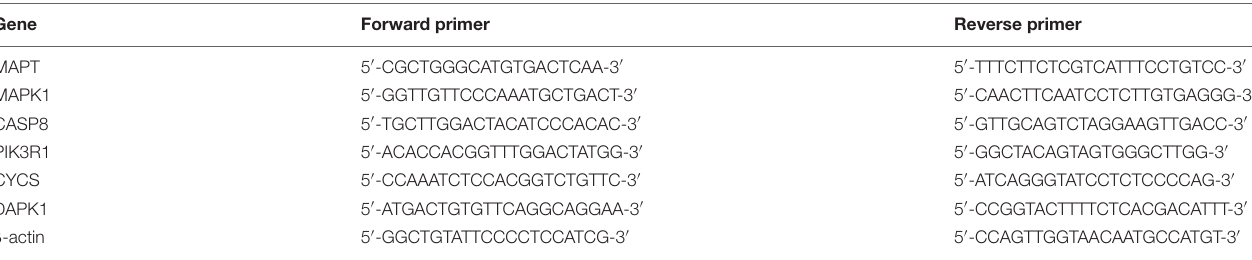
TABLE 1 | The primer sequences for real-time